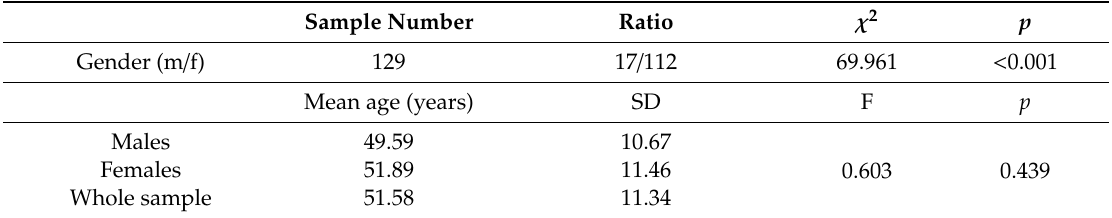
Table 2. Sociodemographic and clinical characteristics of the study